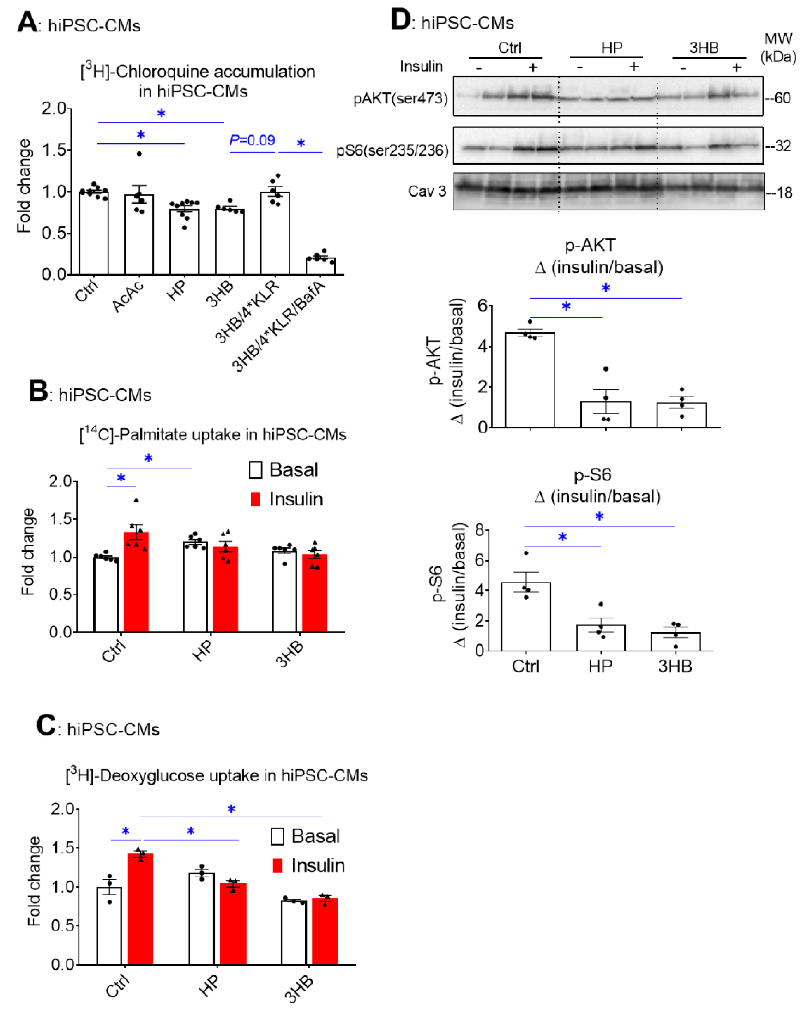
Figure 6. Chronic 3HB exposure reduces v-ATPase activity and insulin sensitivity in human cardi- omyocytes . HiPSC-CMs were cultured for 24 h in either control medium (Ctrl), high palmitate me- dium (HP), Ctrl with 3mM Acetoacetate (AcAc), Ctrl with 3mM 3- β -hydroxybutyrate (3HB), 3HB with supplementation of the 4*KLR mixture (3HB/4*KLR), and with 100 nM Baf (3HB/4*KLR/BafA). ( A ) V-ATPase function in hiPSC-CMs: after culturing, cells were subjected to the [3H] CHLQ accu- mulation assay (n = 9). ( B , C ) After 24 h, cells were short-term (30 min) incubated without/with 200 nM insulin. ( B ) [14C]palmitate uptake (n = 6). ( C ) [3H] deoxyglucose uptake (n = 3). ( D ) Insulin signaling: Western analysis of phosphorylation of Akt and S6 at Ser473 and Ser235/236, respectively. Representative blots of pAKT and pS6 and Caveolin-3 (loading control) are displayed (n = 4). Bar values are means ± SEM. * p < 0.05. The dots represent the measurements that are performed under ‘basal’ condition. The triangles represent the measurements that are performed after insulin stimu- lation.